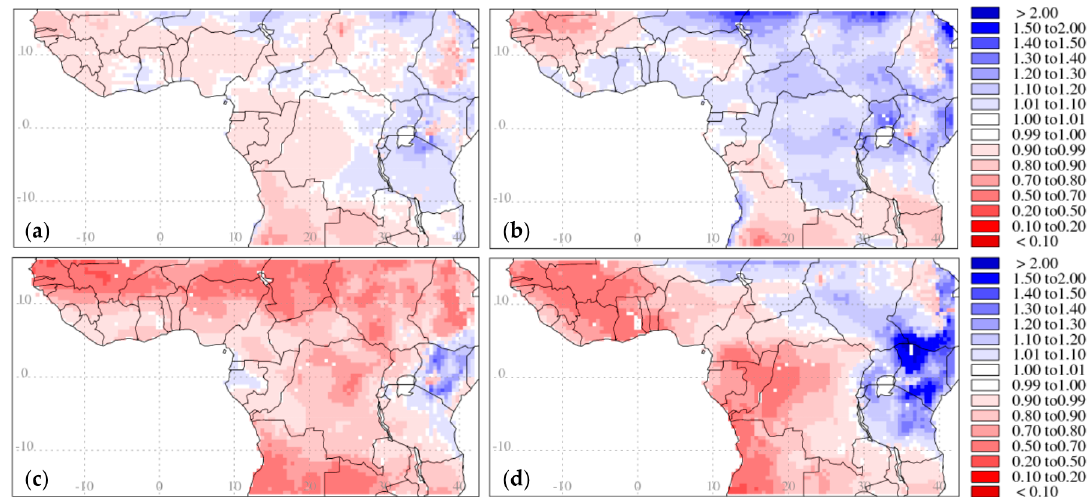
Figure 4. Increase factor of soil water (i.e., the ratio of average available soil water amounts between the annual average over the 2080–2099 period and the reference 1980–1999 period), under the RCP8.5 scenario and a variable CO 2 mixing ratio (CO 2 [var] configuration), for ( a ) the best ranked model CNRM-CM5, ( b ) the most humid model CESM1-BGC, ( c ) the driest model CSIRO-Mk3.6.0, and ( d ) the warmest model